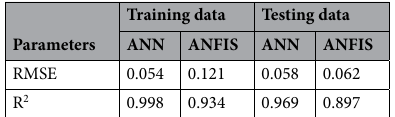
Table 9. Comparison of RMSE and R 2 data for ANN and ANFIS.